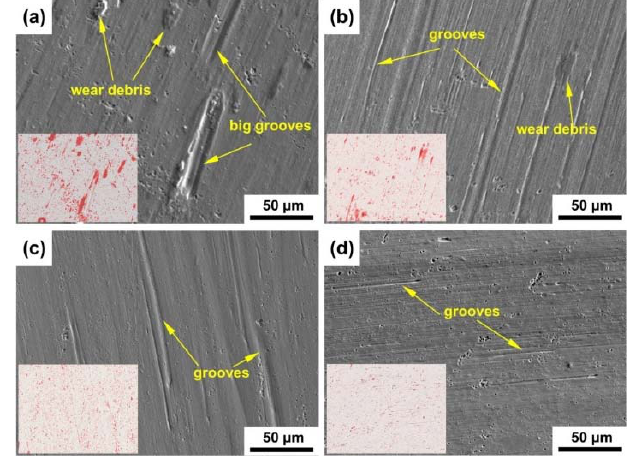
Figure 11. SEM characterizations of the worn surface of M50 steel with different USP durations: ( a ) 0 min; ( b ) 1 min; ( c ) 5 min; ( d ) 10 min.